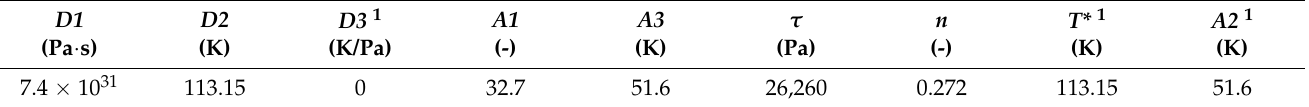
Table 2. WLF parameters for viscosity as function of temperature for any shear rates.